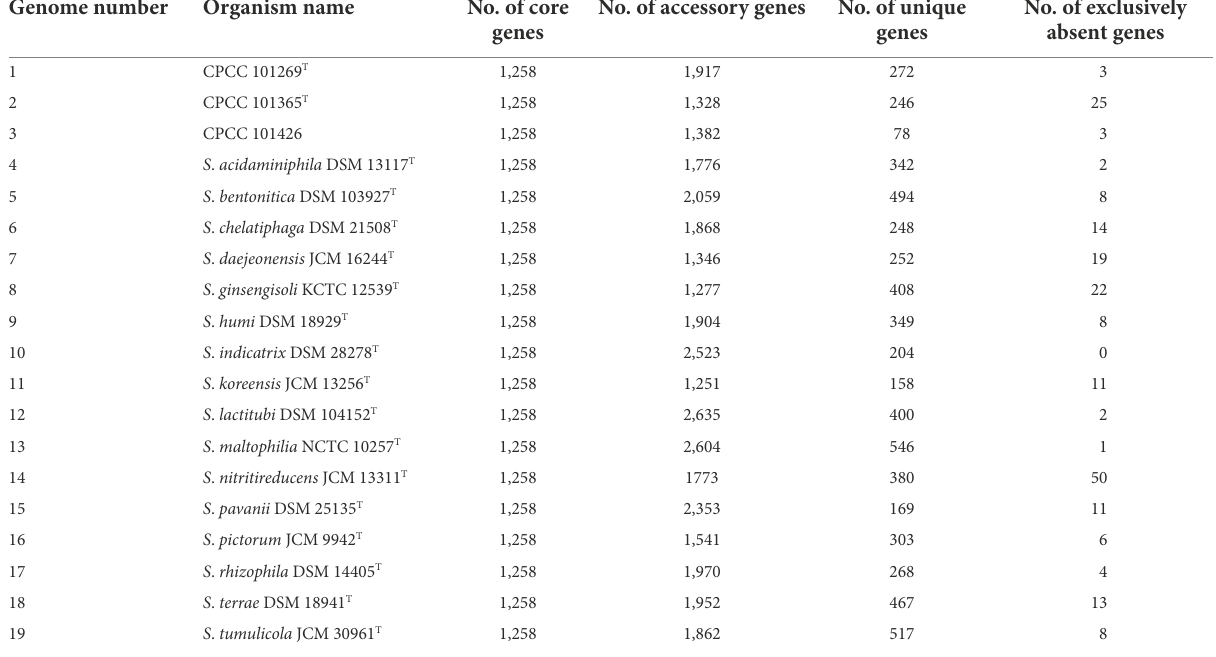
TABLE 2 The pan-genome profile information of the genus Stenotrophomonas . Genome